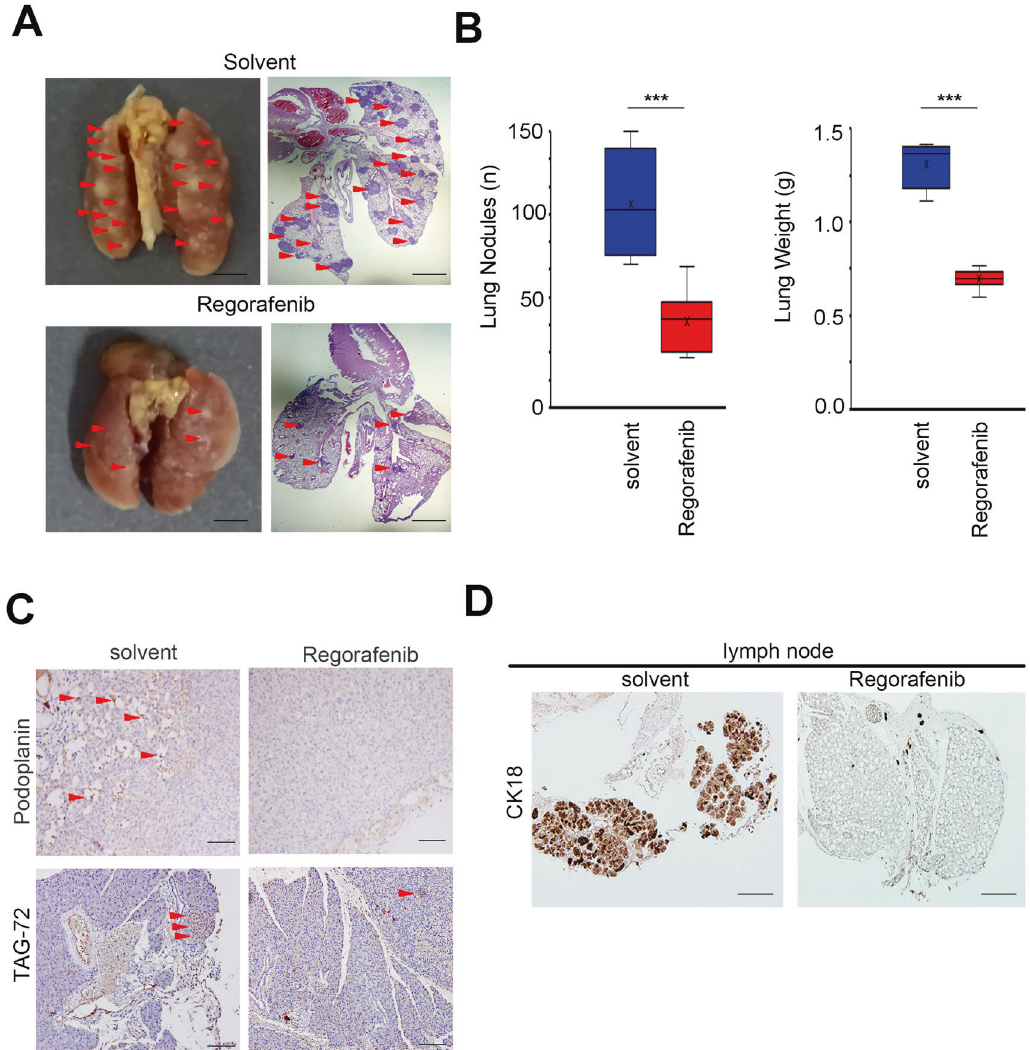
Fig. 5 Regorafenib inhibits lung foci formation and metastatic ability of CCA in vivo. A Metastatic lung foci (indicated by arrows in the left panel) in mice ( n = 6) implanted with HuCCT1 cells through tail vein injection and foci morphology (middle panel, ×12.5 magni fi cation and right panel, ×100 magni fi cation). B Quanti fi ed plot of the number of metastatic lung foci in each group. C Representative IHC staining intensity of podoplanin and TAG-72 protein in lymph nodes of CCA tissues. D Representative IHC staining intensity of CK18 protein in CCA tissues. Scale bar: 50 µm. Scale bar: 50 µm. Data are presented as the mean of three independent experiments ± SEM. The signi fi cance of the difference was determined using a nonparametric Mann – Whitney U